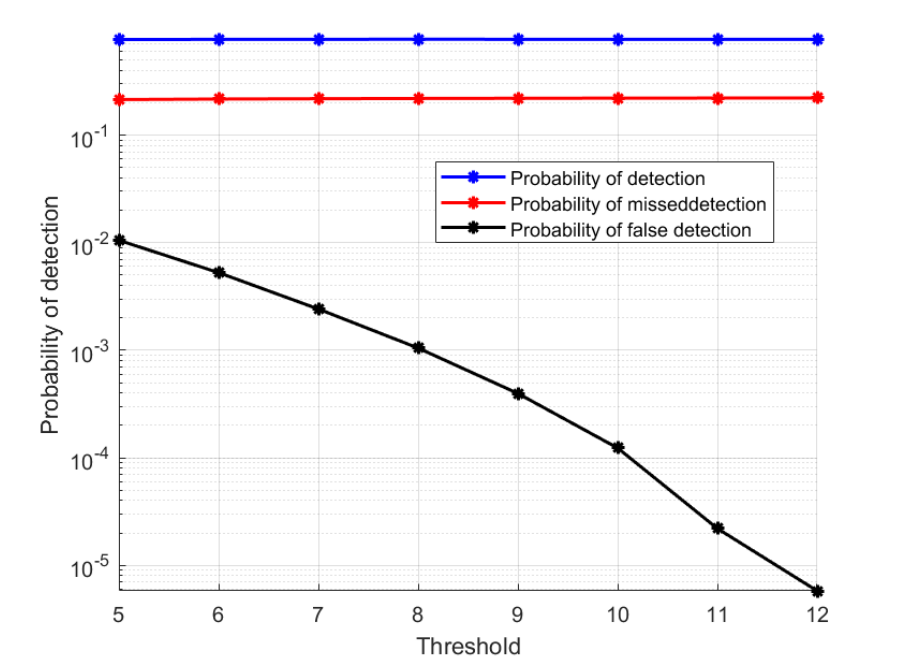
Figure 20. Probability of detection vs. threshold for SNR = 5